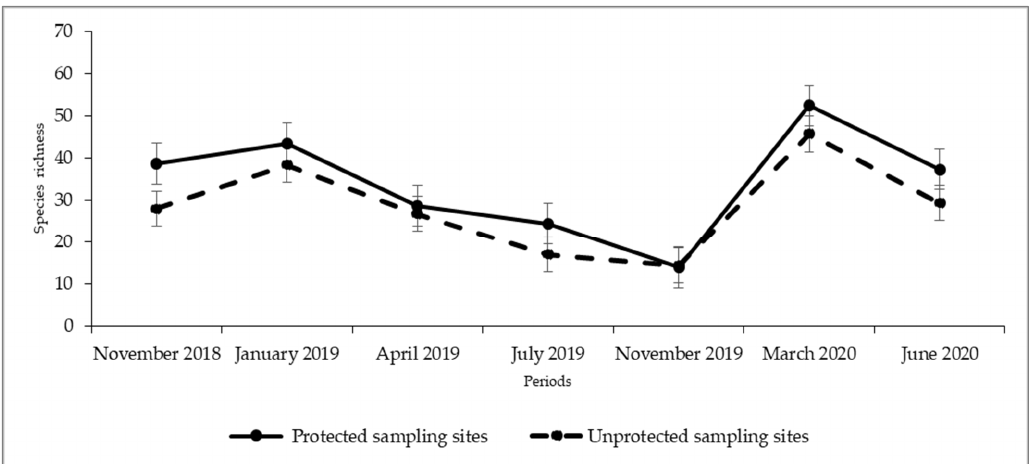
Table 3. Paired t -test of species richness between three protected and three unprotected sites (n = 3 for each). Mean = average species richness of the three study sites.